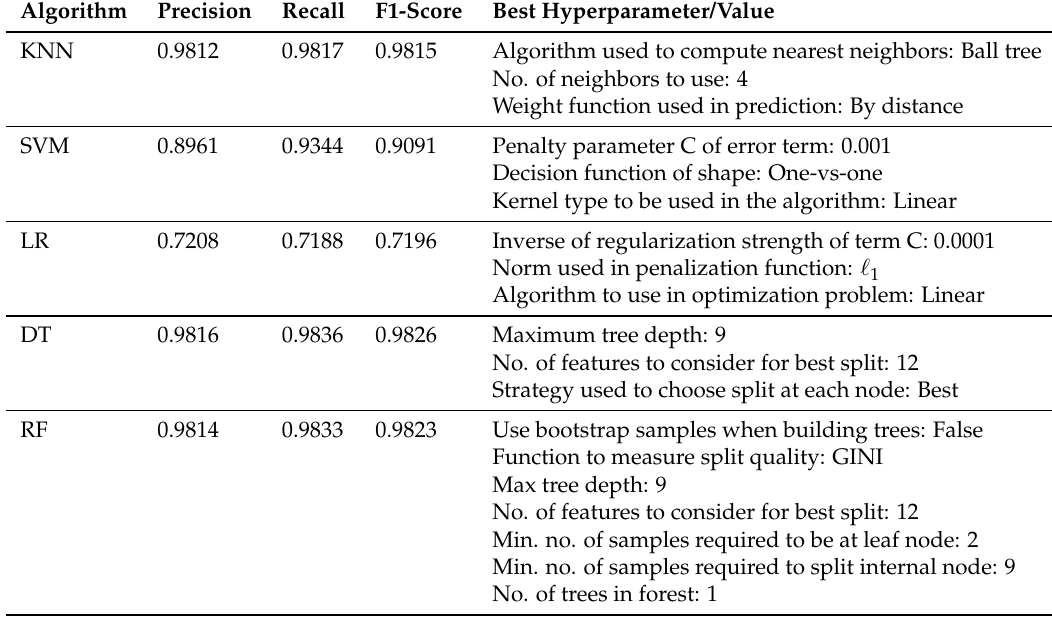
Table 8. CIDDS-001 (SMOTE + GS)